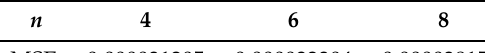
Table 14. n Selection for MU.